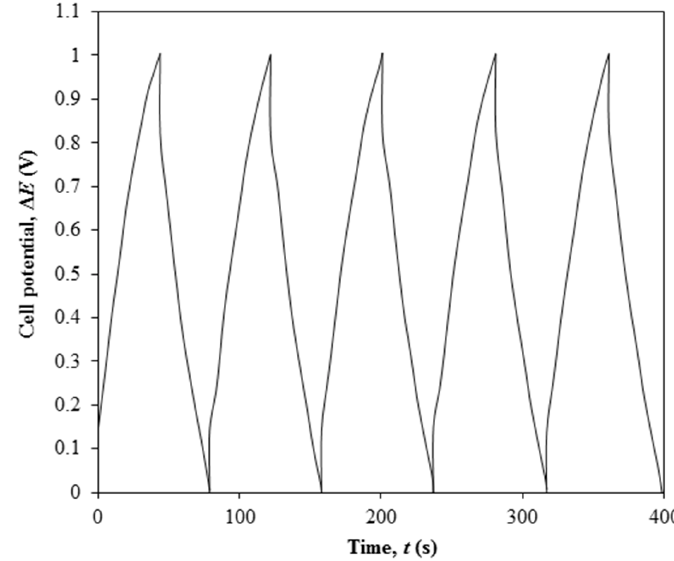
Figure 5. Galvanostatic charge-discharge result of Ti 3-based EDLC upon 5 cycles of charging and discharging.